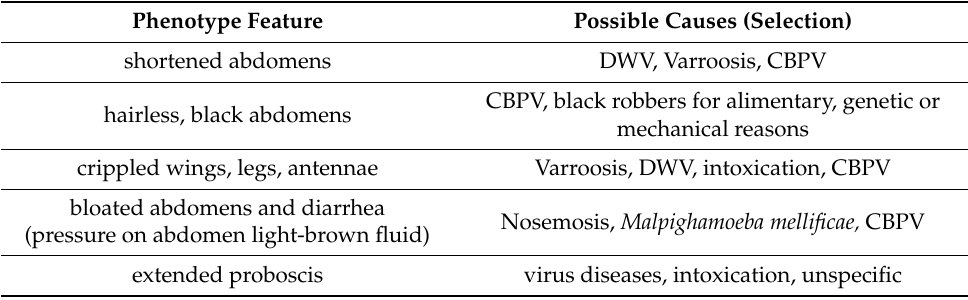
Table 2. Phenotype changes in honeybees and their possible